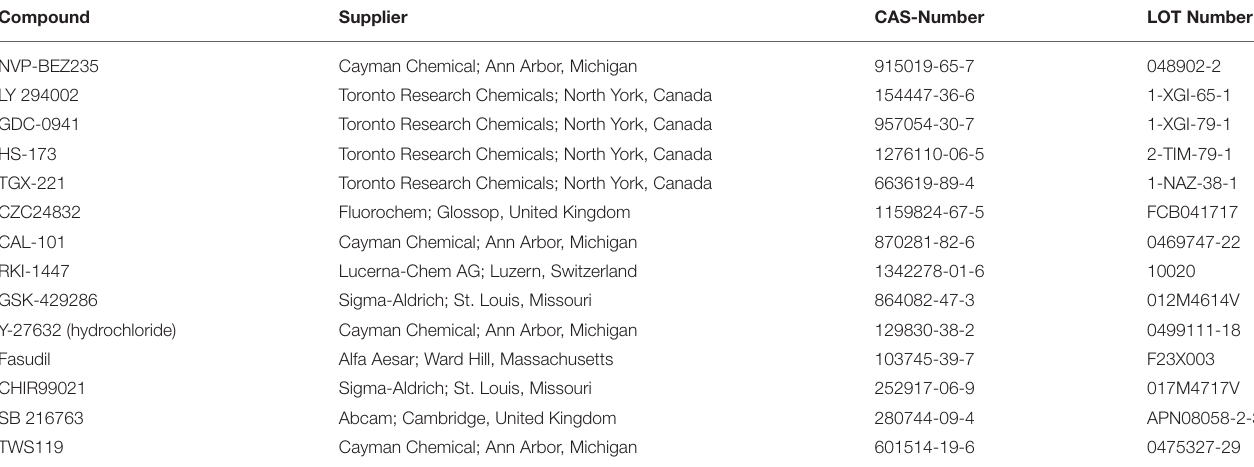
TABLE 1 | Test compounds.